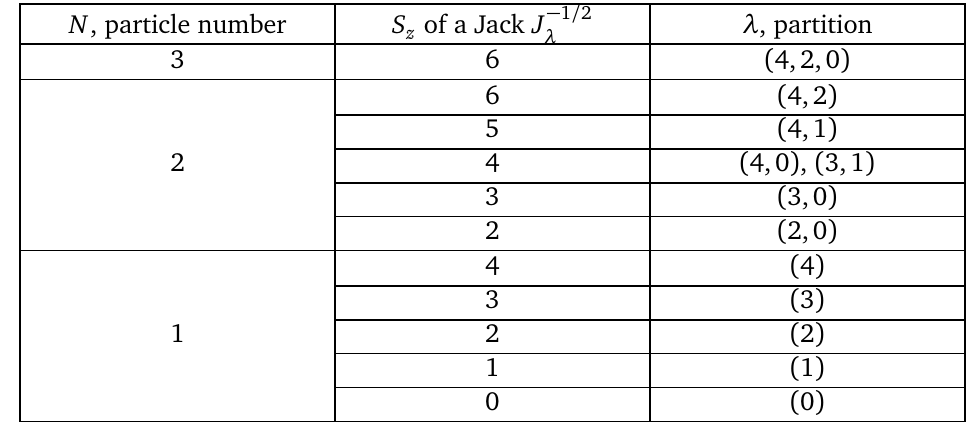
Table 1: List of ( 2,2, N ) -admissible partitions λ for N φ = 4. These root partitions give rise to Jack polynomials with the corresponding value of S particular, this implies that Laughlin state, N = 3, has vanishing angular momen- tum). The resulting wave-functions can be used to construct the basis of quasihole states with different N for a given N φ . As a sanity check, we note that the total